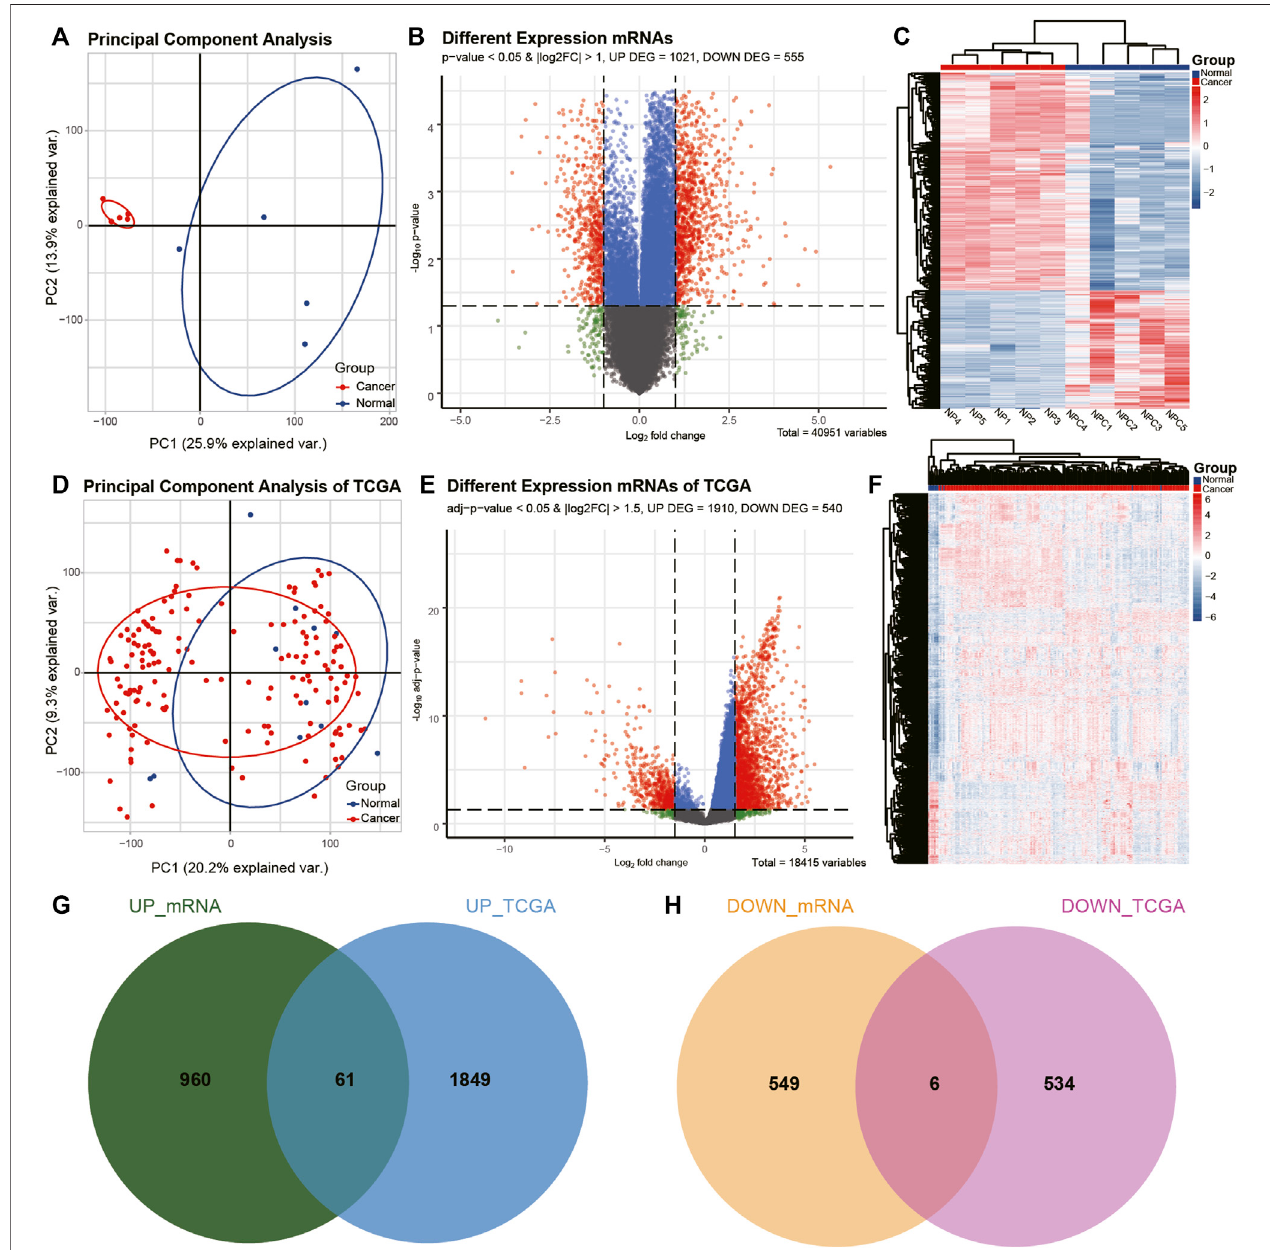
FIGURE2| Identi fi cationofdifferentiallyexpressedmRNAs(DEmRNAs)inECA. (A,D) PCAofmRNAexpressionbetweenECAandnormalgroupsinTCGAcohort and the present RNA-seq data. (B, E) Volcano plot of the distributions of all differentially expressed mRNAs in TCGA cohort and the current RNA-seq data. (C, F) Hierarchical clustering heatmap of dysregulated mRNAs between ECA and the adjacent normal tissues in TCGA cohort and the present RNA-seq data. (G, H) Comparison of differentially expressed mRNAs identi fi ed in TCGA cohort and our RNA-seq data.